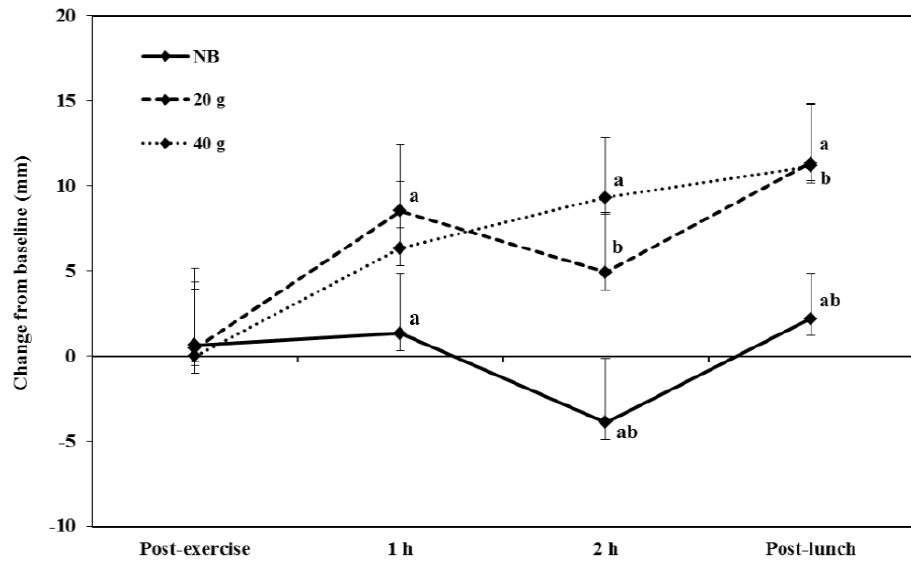
Figure 3. The effects of consuming breakfast cereal (20 g or 40 g) or no breakfast (NB) prior to exercise on feelings of relaxation immediately, 1 and 2 h post-exercise and post-lunch, in habitually active females ( n = 24). Points which share a letter are significantly different from one another (* p < 0.05)